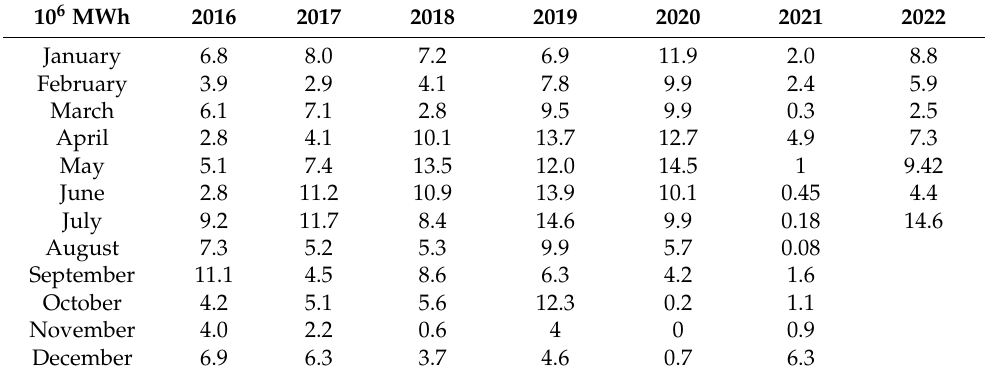
Table 7. Italy/Switzerland. Entry point.